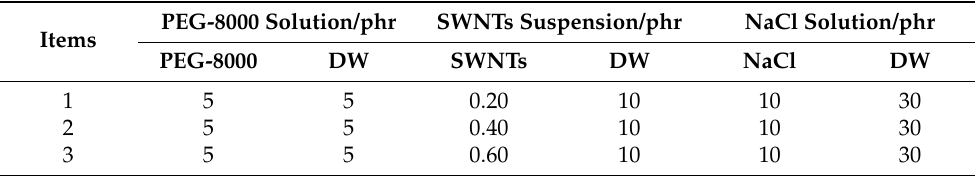
Table 2. Formulation design of dielectric microcapsules.